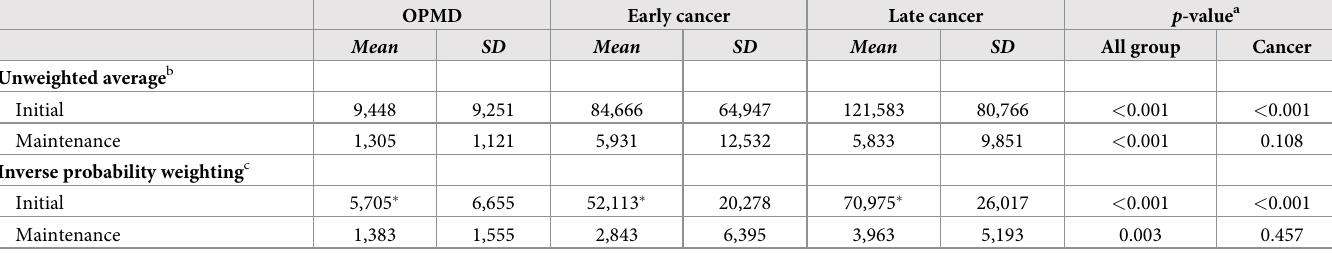
Table 4. Annual cost estimate per patient (in